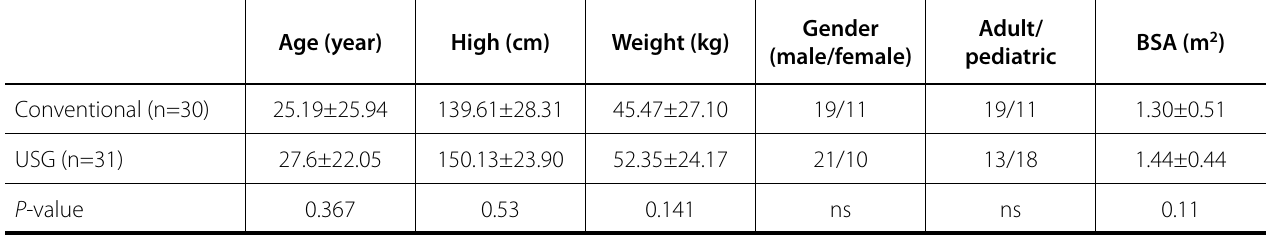
Table 1 . Demographic data of the patients in the conventional cannulation group and the preoperative USG-guided cannulation